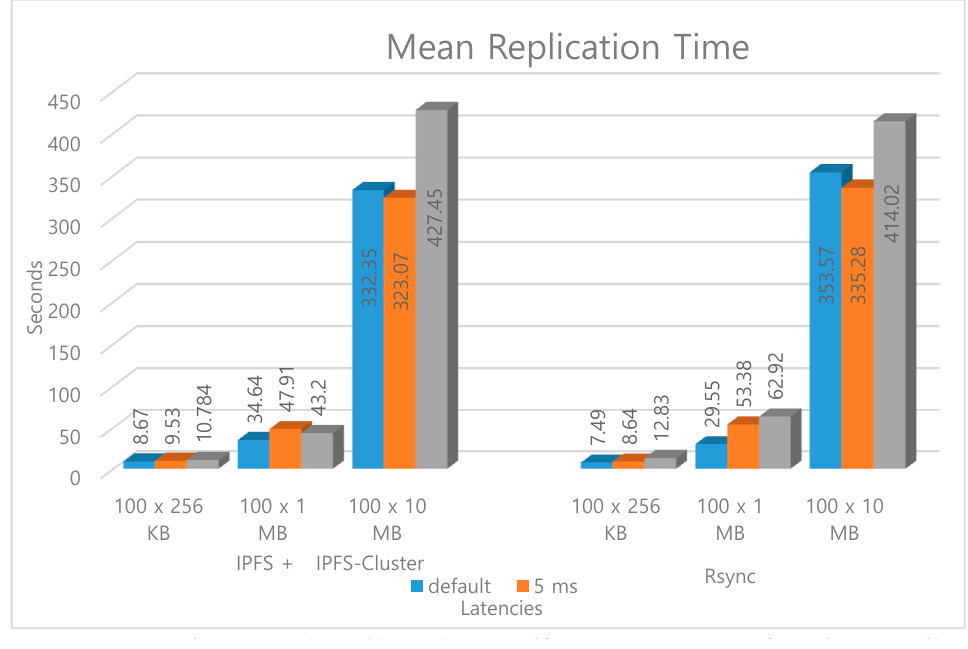
Figure 11. Mean of time to replicate files with a size of {25.6 MB, 100 MB, 1 GB} as a function of latency.